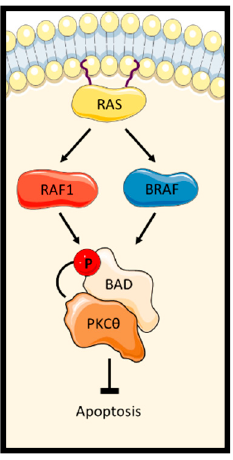
Figure 5. RAF1 and BRAF regulate the activation of apoptosis by modulating PKC θ phosphoryla- tion of